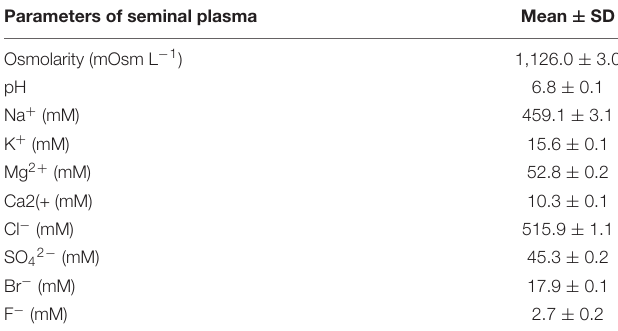
TABLE 2 | Seminal plasma compositions of Pacific abalone, H. discus hannai ( n =